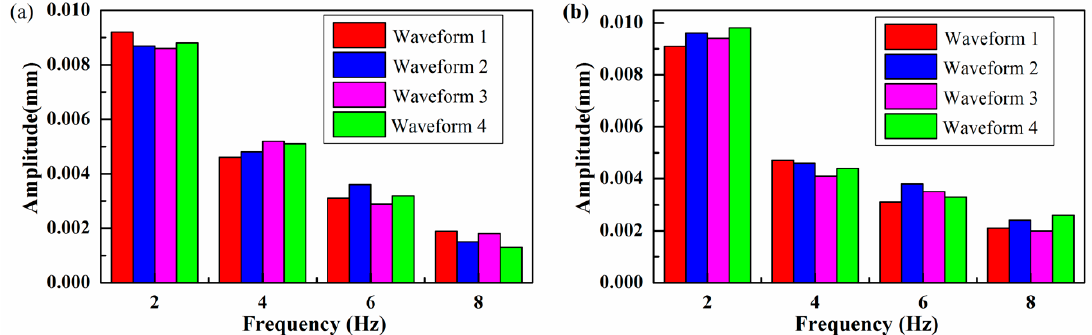
Figure 20. Amplitude corresponding to frequency 2 Hz, 4 Hz, 6 Hz, 8 Hz. ( a ) PB is the measured plane ( b ) PA is the measured plane.